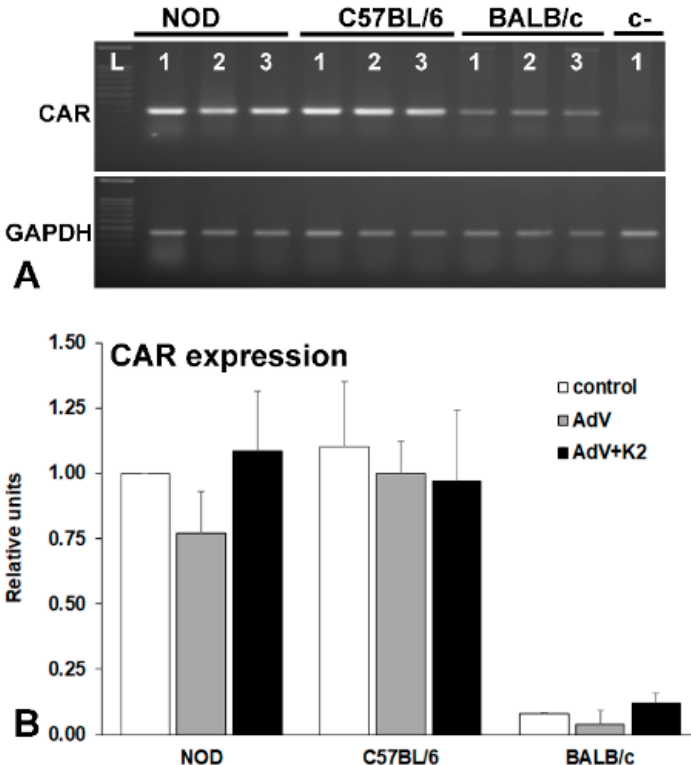
Figure 5. Evaluation of coxsackievirus and adenovirus receptor (CAR) expression in MSC derived from NOD, C57BL/6, and BALB/c mice analyzed by RT-PCR ( A ) and by Q-PCR ( B ). CAR expression is higher in NOD- and C57BL/6-MSC, as compared with that in BALB/c-MSC ( A , lane 1 and B , white columns) and is not modified by the adenovirus ( A , lane 2 and B , grey columns) or by the K2TS ( A , lane 3 and B . black columns).